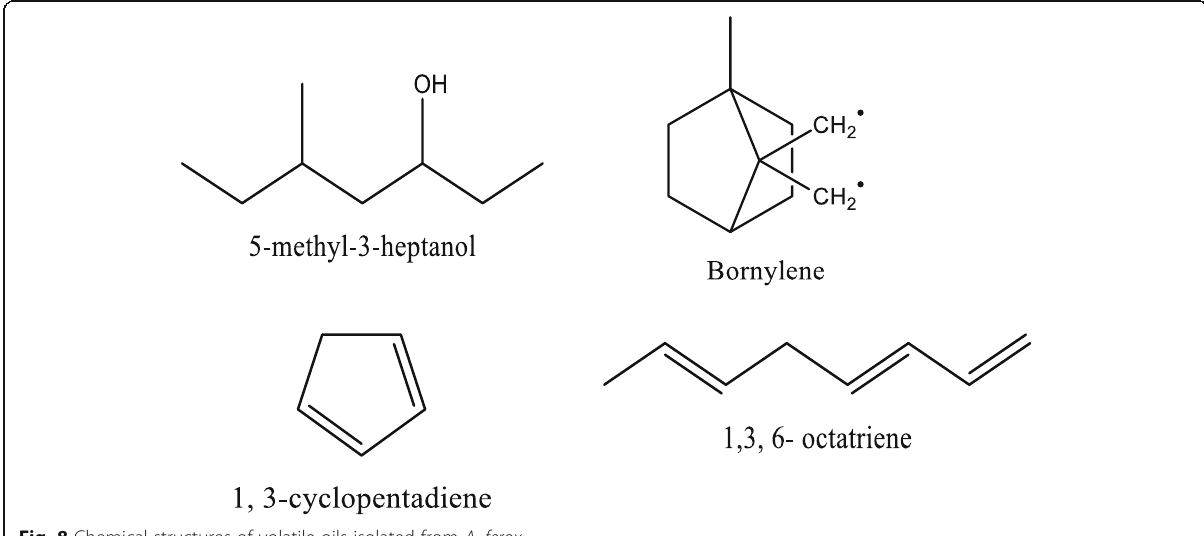
Fig. 8 Chemical structures of volatile oils isolated from A. ferox